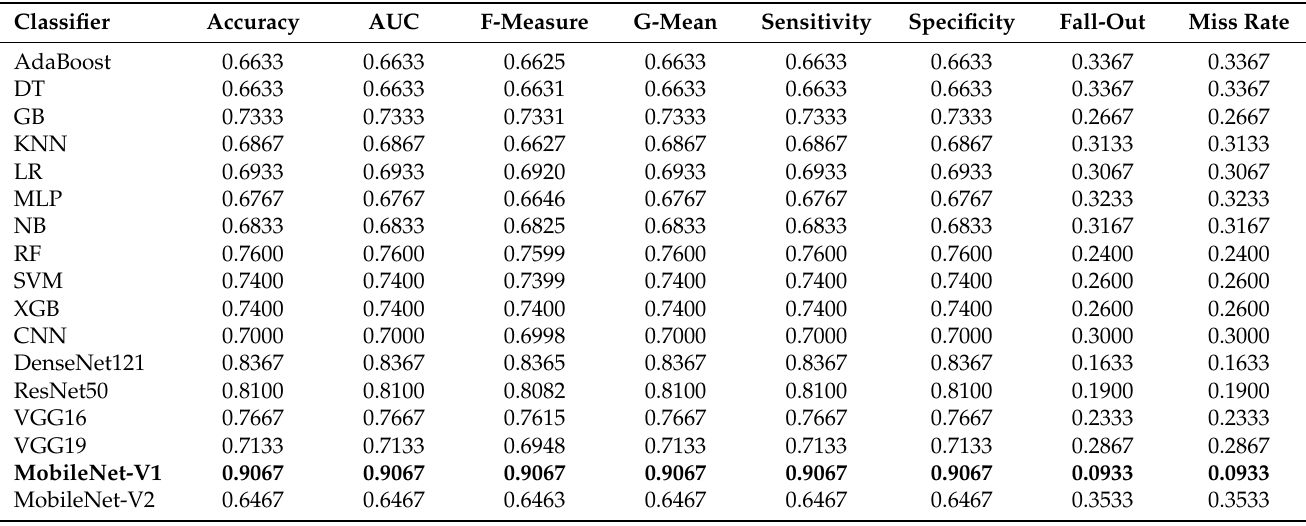
Table 2. Performance Analysis of Test Set using Machine Learning Classifiers and Improved Pretrained Models.